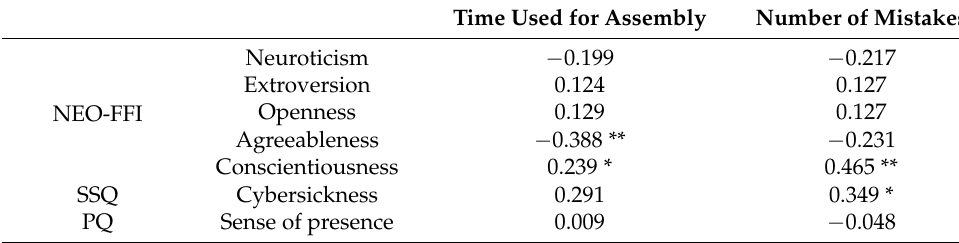
Table 2. Pearson’s correlations between the analyzed NEO-FFI and performance